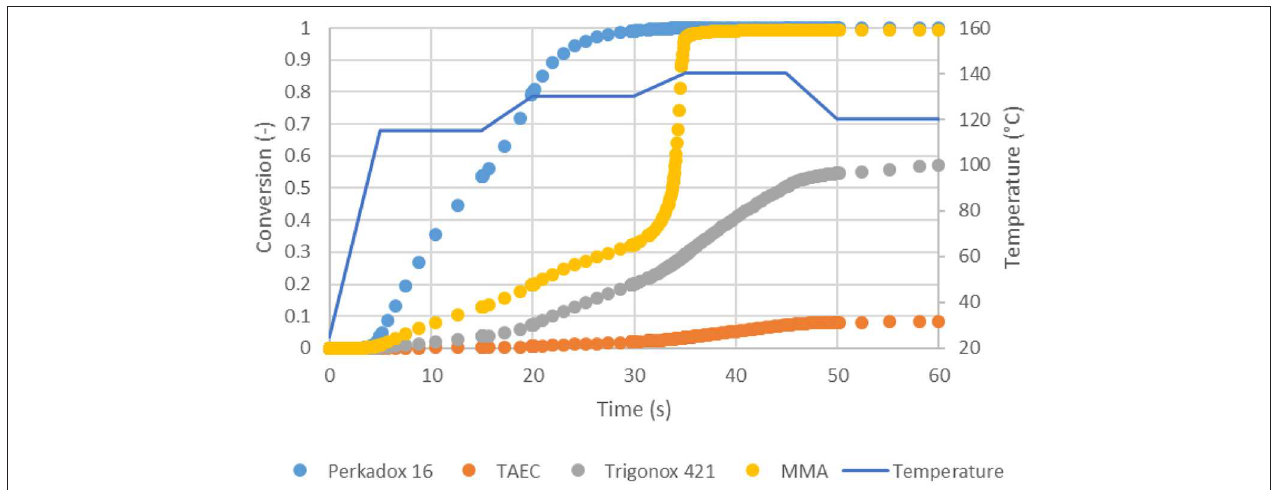
FIGURE 6 | Alternative PREDICI simulation of the conversion of the initiators Perkadox 16 (blue points), Luperox TAEC (orange points), Trigonox 421 (gray points), the monomer methyl methacrylate (MMA) (yellow points), and the temperature (zone 1: 115 ◦ C, zone 2: 130 ◦ C, zone 3: 140 ◦ C, zone 4: 120 ◦ C) (blue line).